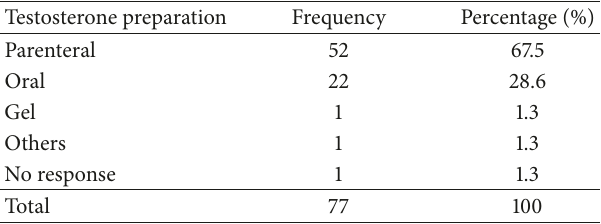
Table 3: Form of testosterone